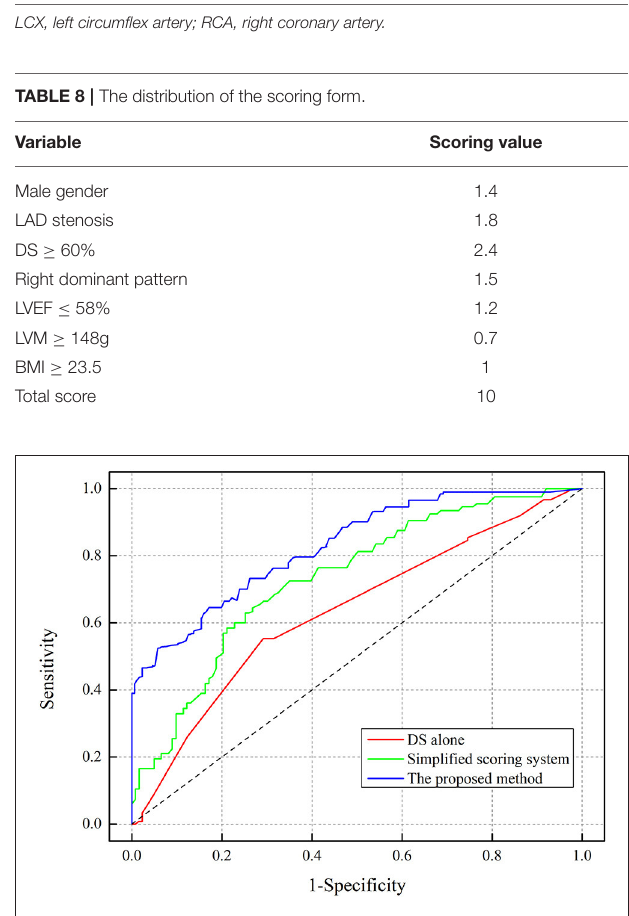
FIGURE 3 | Receiver-operating characteristic (ROC) curve analysis for determining the area under curve